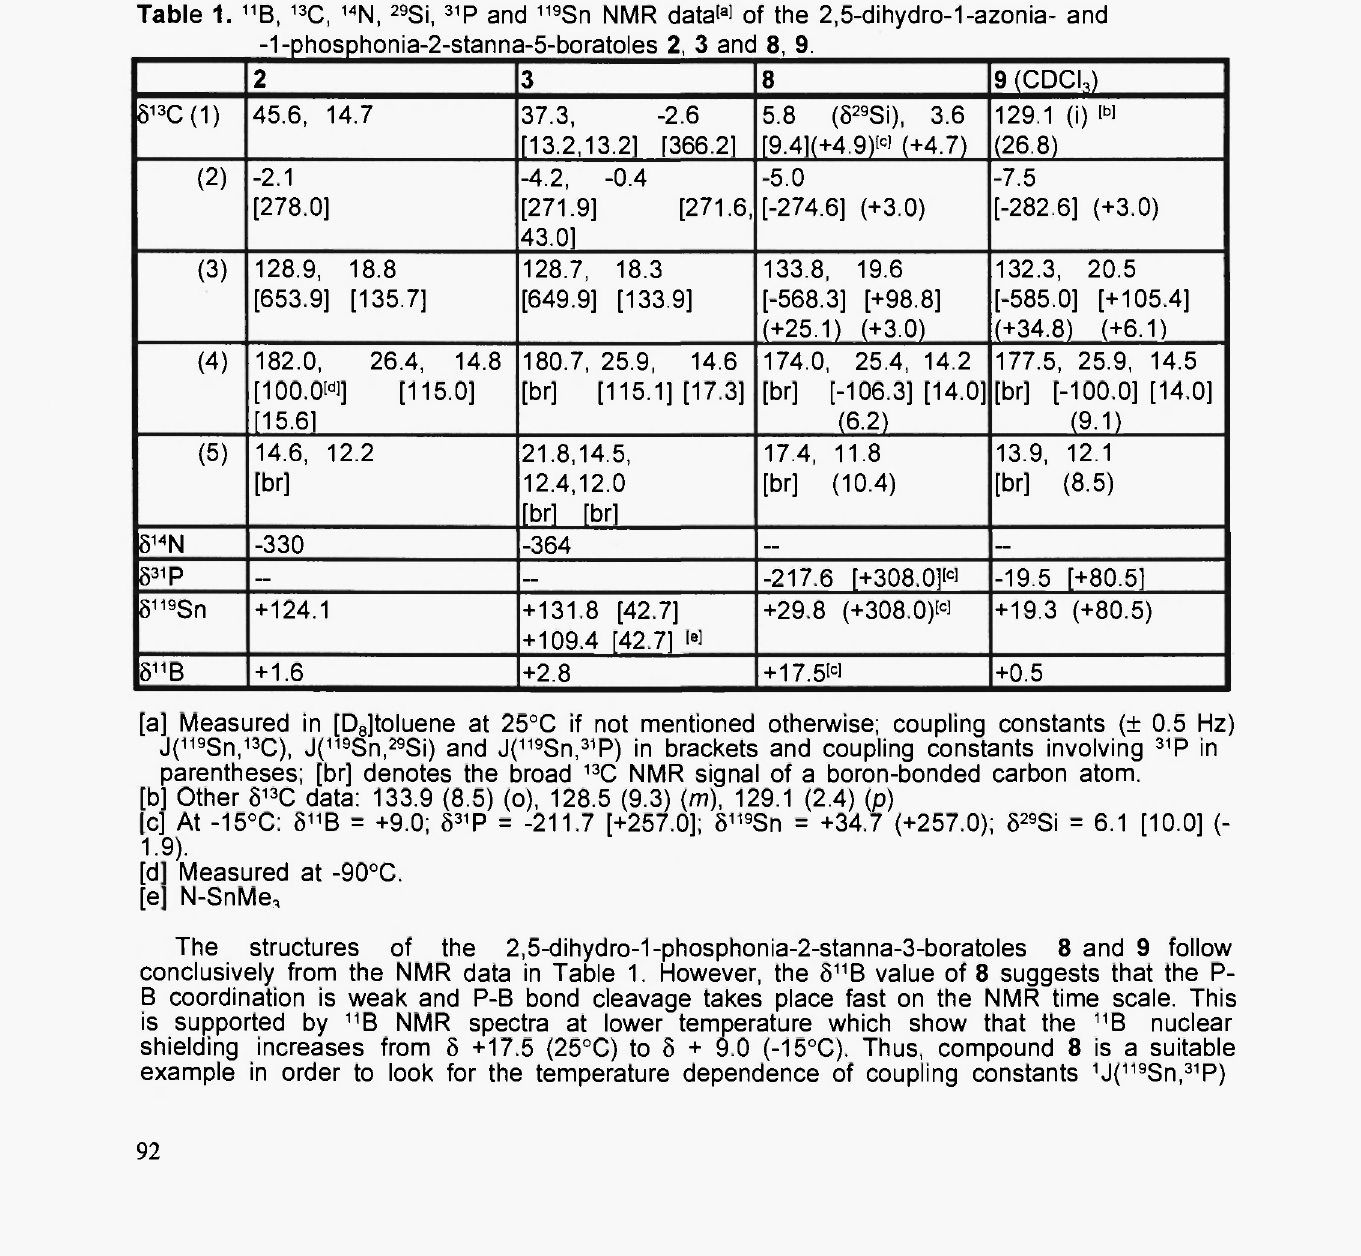
Table 1. 11 B, 13 C, 14 N, 29 Si, 31 P and 119 Sn NMR data^ of the 2,5-dihydro-1-azonia-